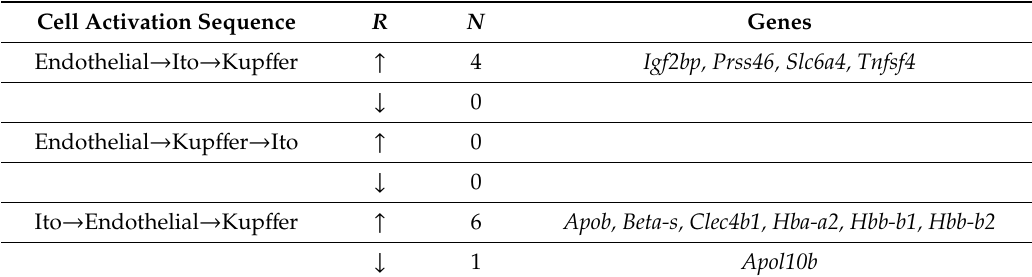
Table 2. Cell activation sequence in the control cells (fold change 2 in log 2 scale). For each mRNA sample we used 4 biological